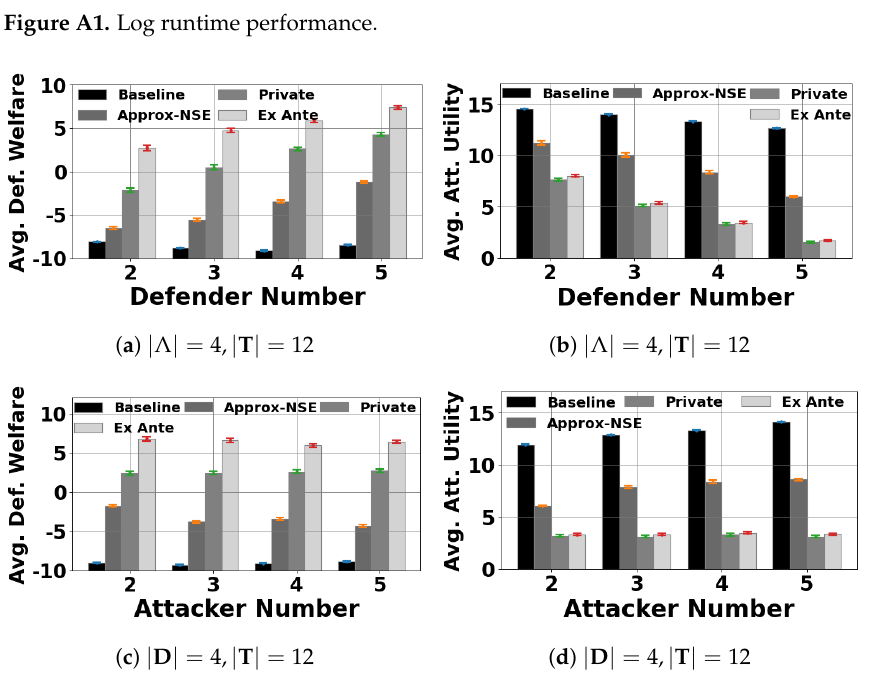
Figure A2. All evaluated algorithms, no patrolling costs.